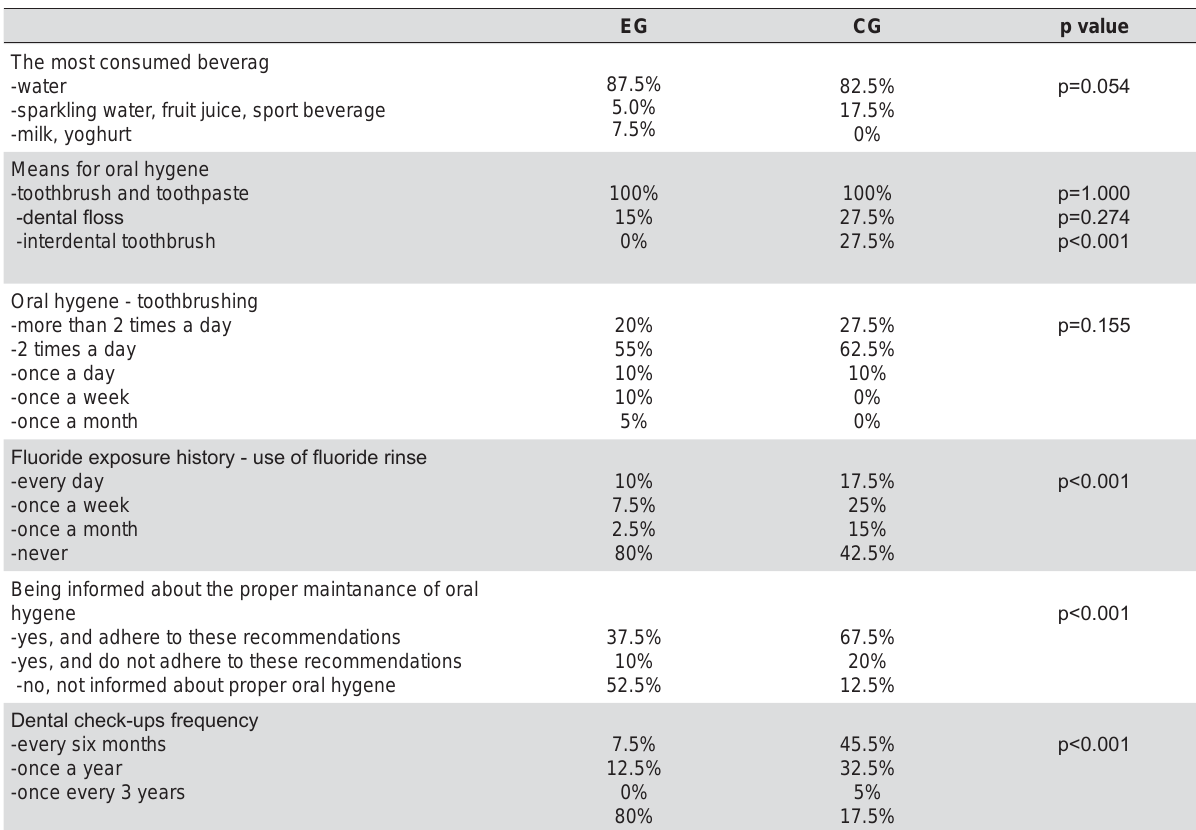
Table 3- (cid:3)(cid:54)(cid:87)(cid:88)(cid:71)(cid:92)(cid:3)(cid:86)(cid:68)(cid:80)(cid:83)(cid:79)(cid:72)(cid:3)(cid:82)(cid:73)(cid:3)(cid:72)(cid:91)(cid:83)(cid:72)(cid:85)(cid:76)(cid:80)(cid:72)(cid:81)(cid:87)(cid:68)(cid:79)(cid:3)(cid:74)(cid:85)(cid:82)(cid:88)(cid:83)(cid:3)(cid:11)(cid:40)(cid:42)(cid:12)(cid:3)(cid:68)(cid:81)(cid:71)(cid:3)(cid:70)(cid:82)(cid:81)(cid:87)(cid:85)(cid:82)(cid:79)(cid:3)(cid:74)(cid:85)(cid:82)(cid:88)(cid:83)(cid:3)(cid:11)(cid:38)(cid:42)(cid:12)(cid:3)(cid:85)(cid:72)(cid:74)(cid:68)(cid:85)(cid:71)(cid:76)(cid:81)(cid:74)(cid:3)(cid:87)(cid:75)(cid:72)(cid:3)(cid:71)(cid:76)(cid:72)(cid:87)(cid:68)(cid:85)(cid:92)(cid:3)(cid:75)(cid:76)(cid:86)(cid:87)(cid:82)(cid:85)(cid:92)(cid:15)(cid:3)(cid:82)(cid:85)(cid:68)(cid:79)(cid:3)(cid:75)(cid:92)(cid:74)(cid:76)(cid:72)(cid:81)(cid:72)(cid:15)(cid:3)(cid:192)(cid:88)(cid:82)(cid:85)(cid:76)(cid:71)(cid:72)(cid:3)(cid:72)(cid:91)(cid:83)(cid:82)(cid:86)(cid:88)(cid:85)(cid:72)(cid:15)(cid:3) (cid:76)(cid:81)(cid:73)(cid:82)(cid:85)(cid:80)(cid:68)(cid:87)(cid:76)(cid:82)(cid:81)(cid:3)(cid:68)(cid:69)(cid:82)(cid:88)(cid:87)(cid:3)(cid:3)(cid:83)(cid:85)(cid:82)(cid:83)(cid:72)(cid:85)(cid:3)(cid:82)(cid:85)(cid:68)(cid:79)(cid:3)(cid:75)(cid:92)(cid:74)(cid:76)(cid:72)(cid:81)(cid:72)(cid:15)(cid:3)(cid:68)(cid:81)(cid:71)(cid:3)(cid:73)(cid:85)(cid:72)(cid:84)(cid:88)(cid:72)(cid:81)(cid:70)(cid:92)(cid:3)(cid:82)(cid:73)(cid:3)(cid:70)(cid:75)(cid:72)(cid:70)(cid:78)(cid:88)(cid:83)(cid:86)(cid:3)(cid:68)(cid:87)(cid:3)(cid:87)(cid:75)(cid:72)(cid:3)(cid:71)(cid:72)(cid:81)(cid:87)(cid:76)(cid:86)(cid:87)